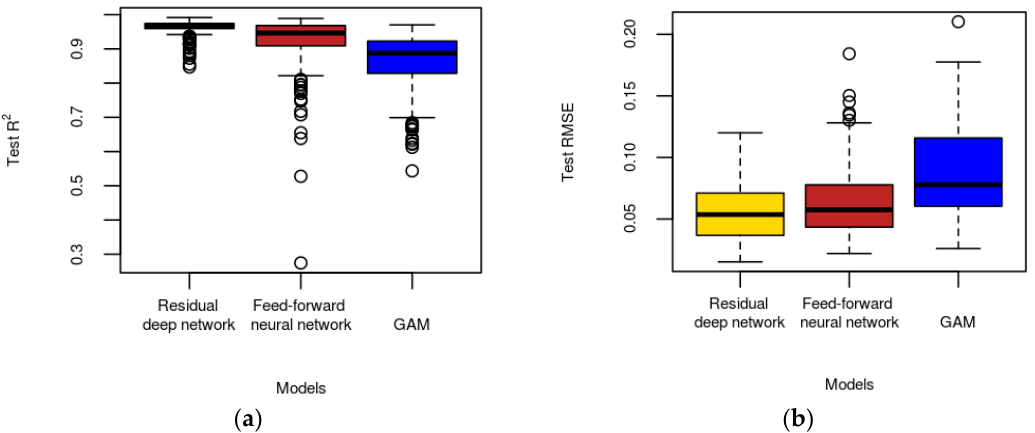
Figure 5. Boxplot of R 2 ( a ) and RMSE ( b ) for three models, i.e., residual deep network, feed-forward neural network and GAM (generalized additive model) in imputations of daily-level MAIAC AOD (yellow: high performance; orange: moderate performance; blue: low performance).